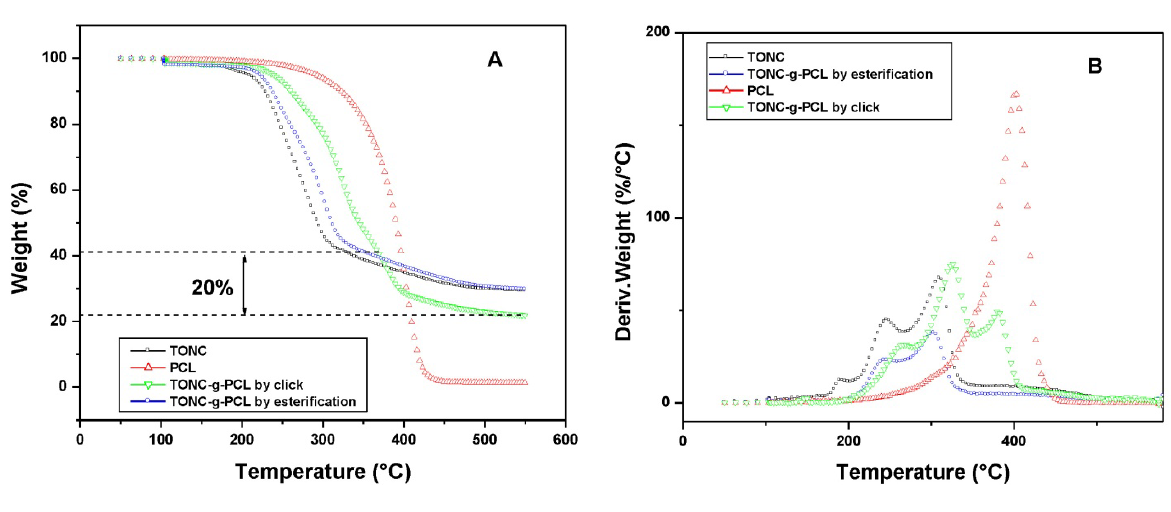
Figure 9. Thermogravimetry analysis (TGA) ( A ) and differential thermogravimetry ( B ) curves of PCL (red curve), TONC (black curve), TONC-g-PCL via esterification reaction (blue curve) and TONC-g-PCL via click reaction (green curve).